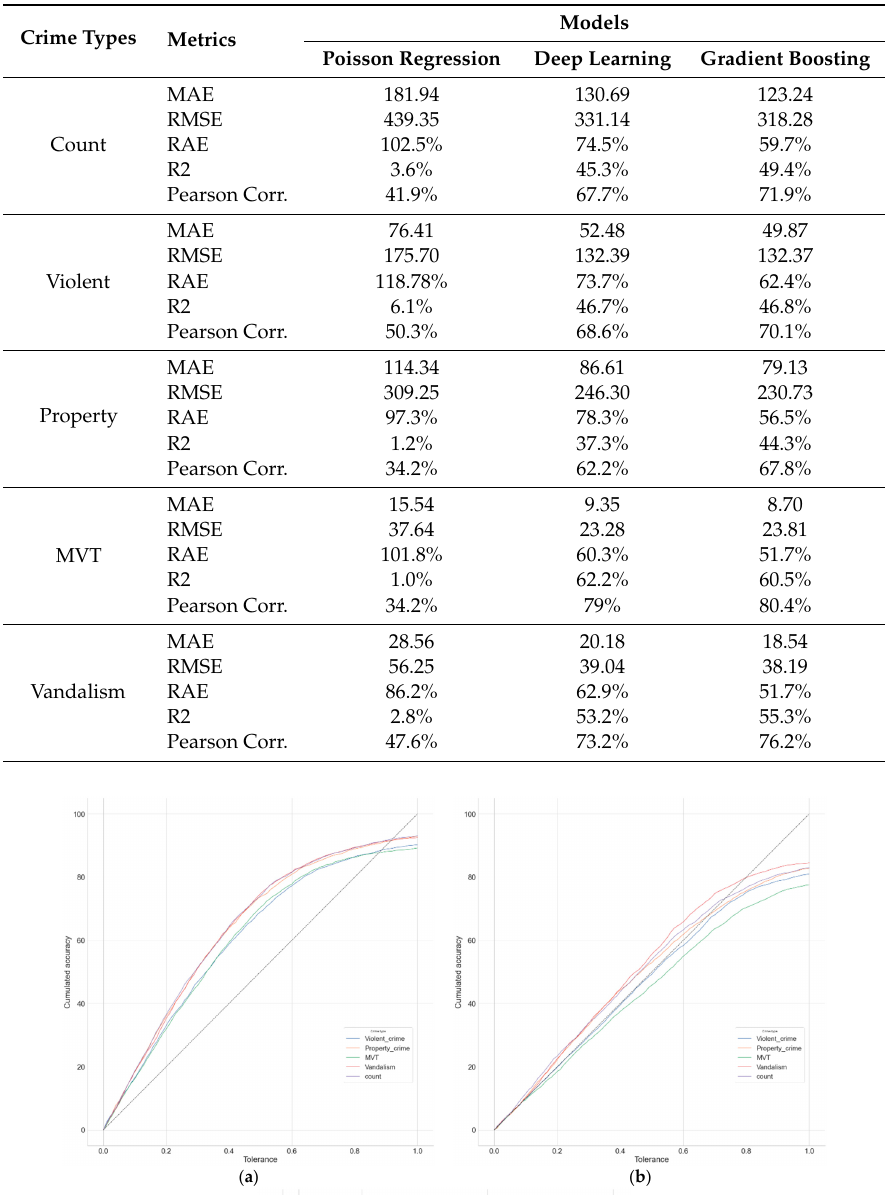
Table 6. Comparison of the performance of three predictive models using di ff erent evaluation metrics.